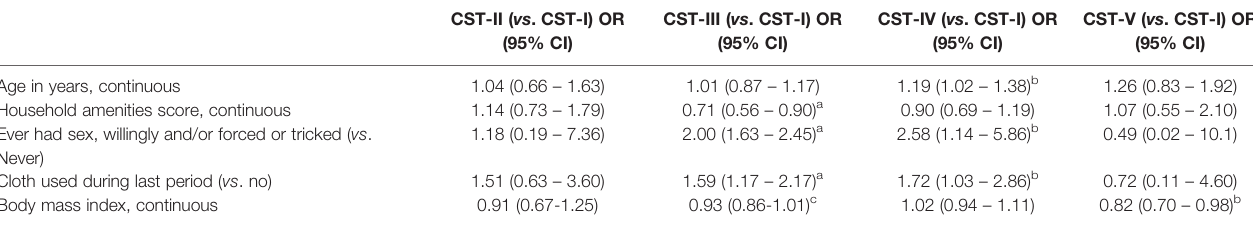
TABLE 4 | Results of multivariable adjusted multinomial logistic regression with random effect for school: factors associated with community state type, N=420.